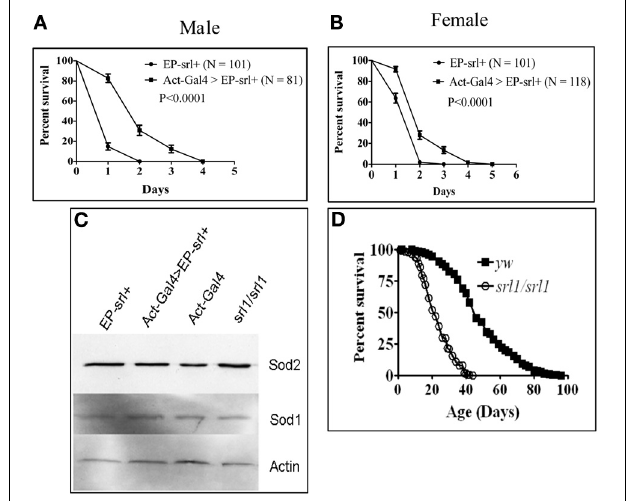
FIGURE 2 | Spargel gain of function was achieved by activating an EP - srl + transgene ubiquitously with the help of Actin-GAL4 driver (see Kapahi et al., 2004, for detail). Percent survival was measured following exposure to 20mM paraquat made in 1% sucrose solution. (A,B) Male and female flies overexpressing Spargel/dPGC-1 survive longer in paraquat than the control indicating that Spargel/dPGC-1 overexpression cause increased resistance to oxidative stress, (C) Spargel/dPGC-1 overexpression or its ablation in srl 1 does not alter the expression of SOD2 and SOD1 antioxidant enzymes, (D) Reduced Spargel/dPGC-1 in srl 1 cause significant reduction in life